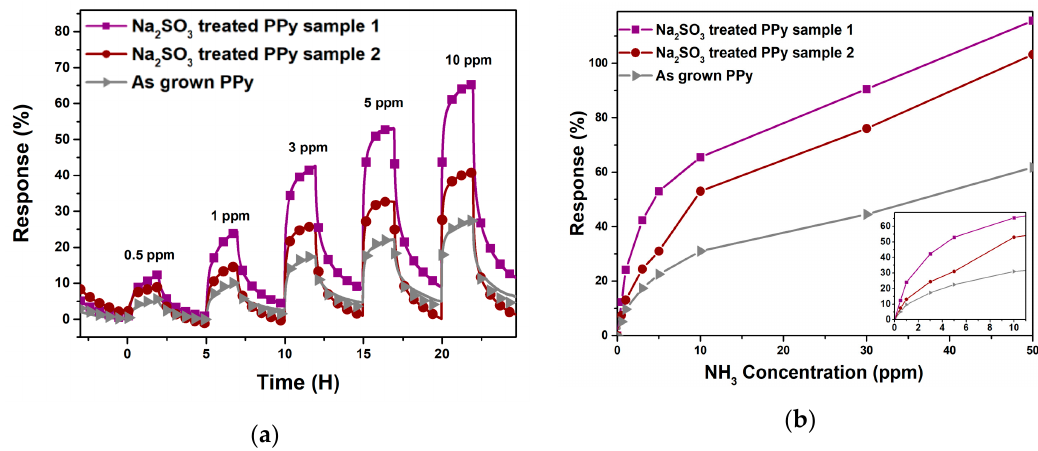
Figure 10. Ammonia sensing test: ( a ) Response and ( b ) calibration curve of as grown PPy sensor and PPy sensors after reduction treatments in Na 2 SO 3 10 wt% solution in demineralized water. Humidity was varied from 20% to 80% (Figure 11). Changes in electric resistance are relatively